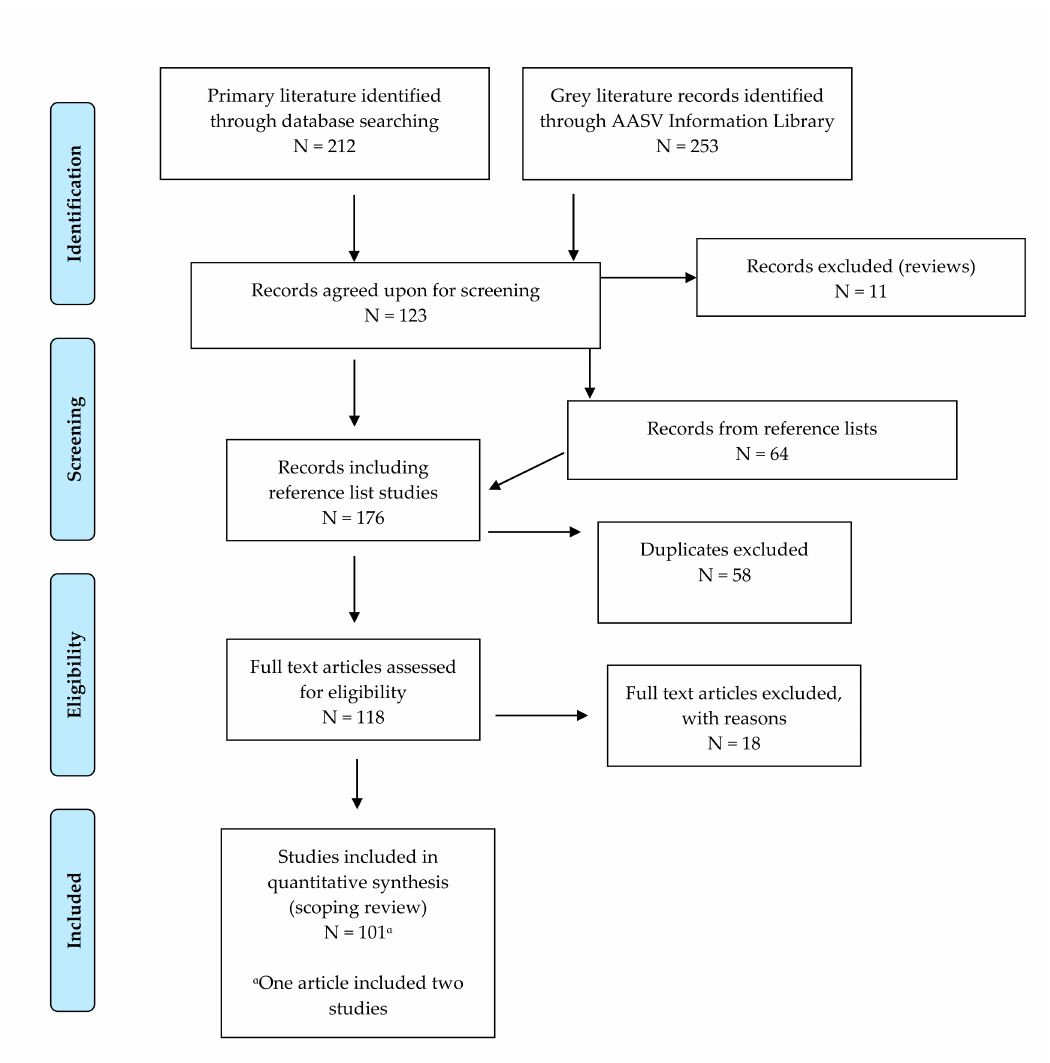
Figure 1. Preferred Reporting Items for Systematic Reviews and Meta-Analyses (PRISMA) flow diagram of included literature in the scoping review process.